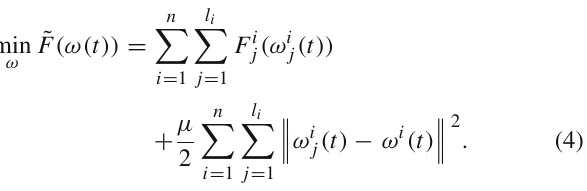
function of the local training to balance the local model